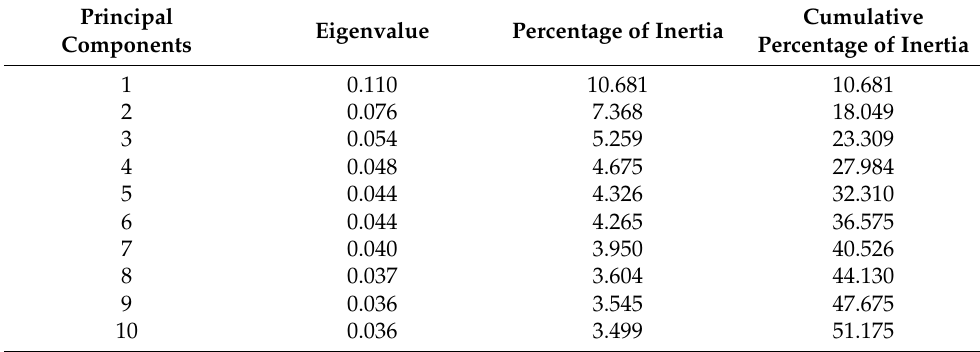
Table 1. Percentage of inertia for the first 10 principal